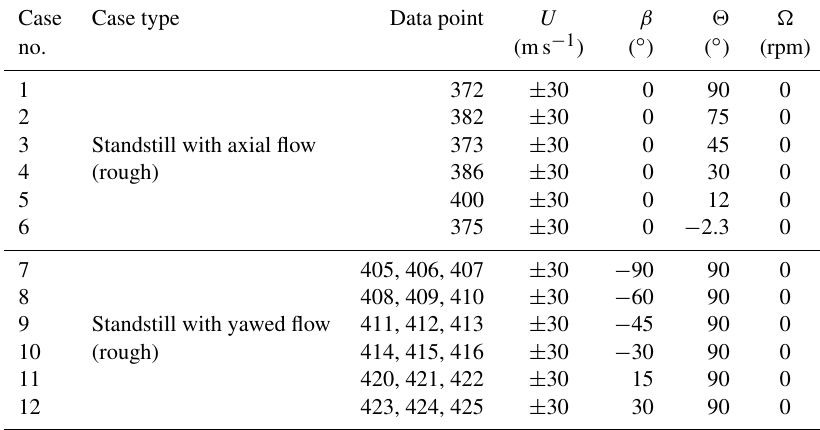
Table 3. Investigated cases from the New MEXICO